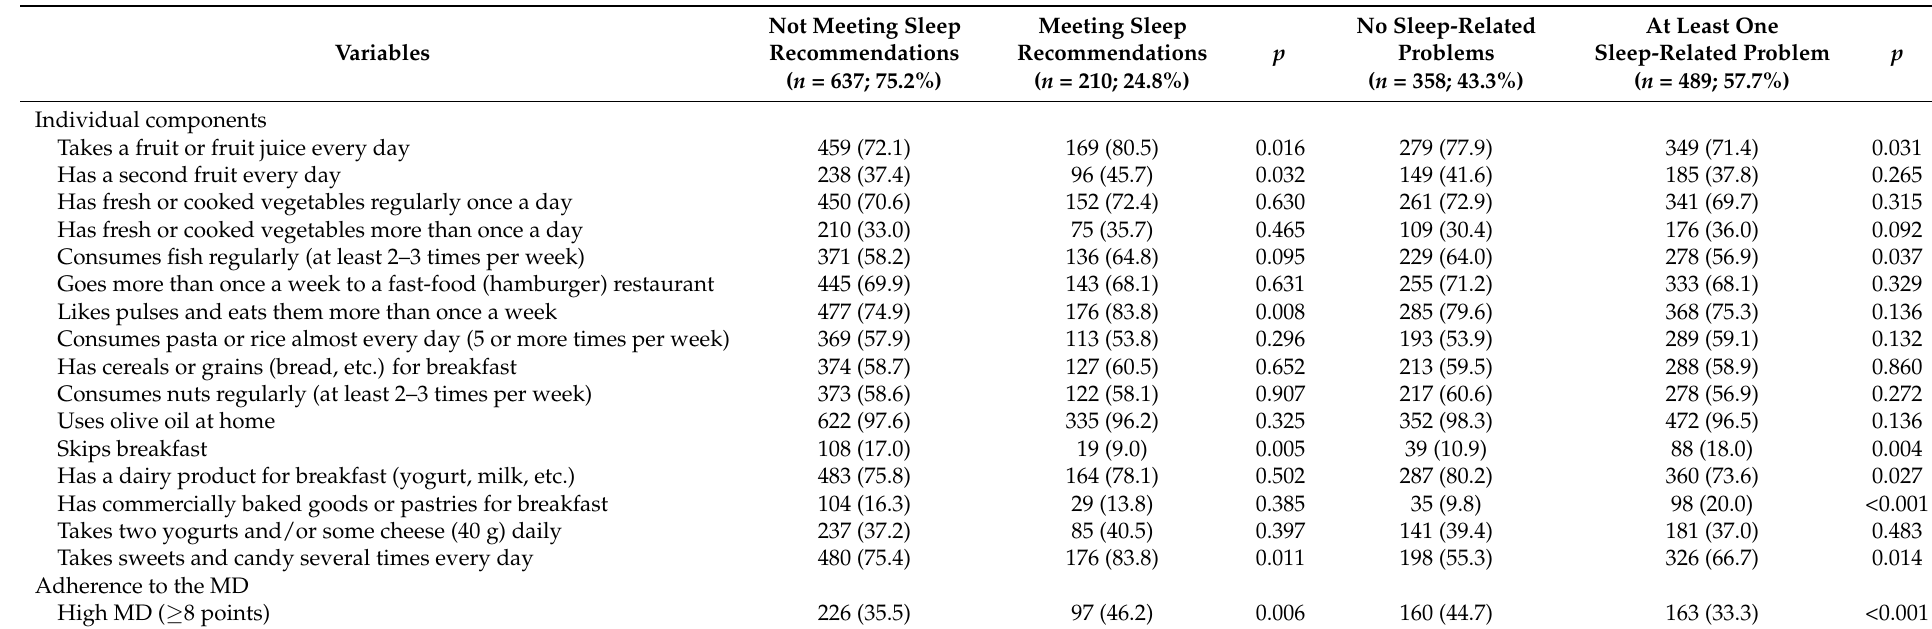
Table 2. Mediterranean Diet Quality Index for Children and Teenagers according to meeting with sleep recommendations or presenting at least one